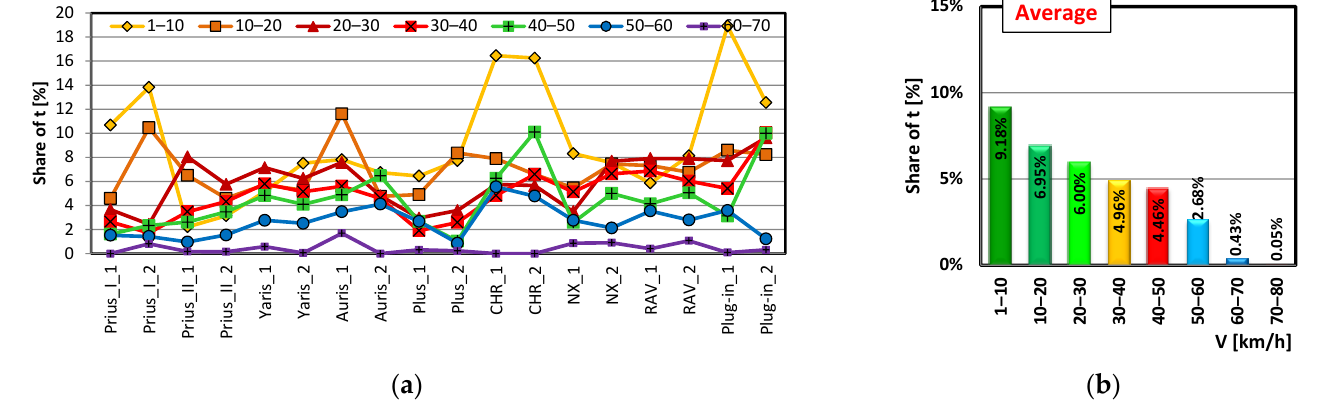
Figure 12. Analysis of the electric mode share of vehicle motion according to interval values of speed: ( a ) for each vehicle; ( b ) average values for all tested vehicles.